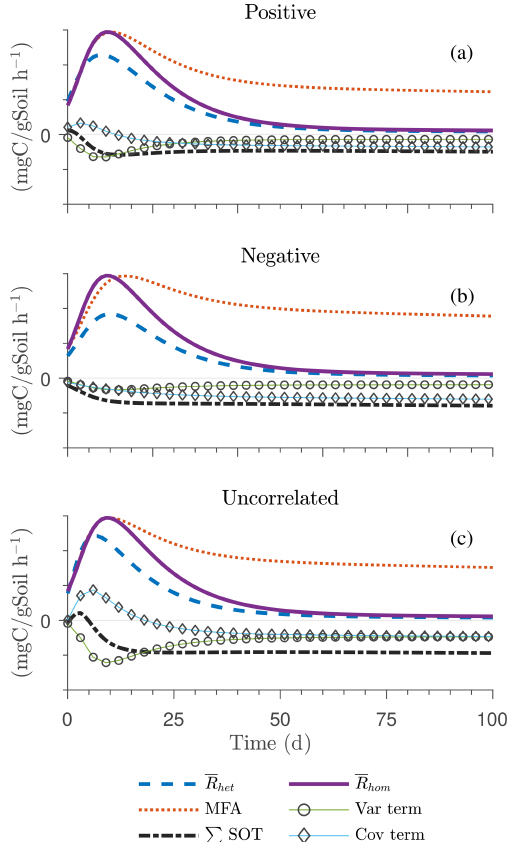
Figure A5. Scenario 2 (HS with Michaelis–Menten kinetics): tem- poral evolution of mean respiration rate in the biophysically het- erogeneous system ( R het , including the mean field approximation (MFA) and second-order terms) and the respiration rate in the ho- mogeneous system ( R hom ) for (a) positively and (b) negatively cor- related or (c) uncorrelated substrate and microbial C.